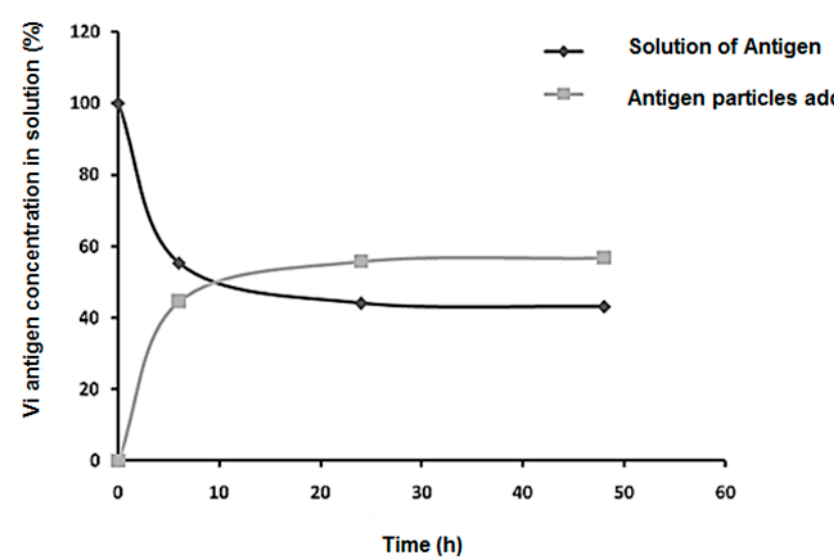
Figure 4. Graph of the kinetics of adsorption of the Vi antigen in a solution of 1%–1% (CS–PMAA) nanoparticles at room temperature.